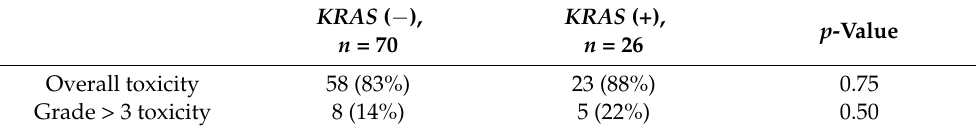
Table 5. Rates of treatment-related adverse events in subgroups by KRAS status